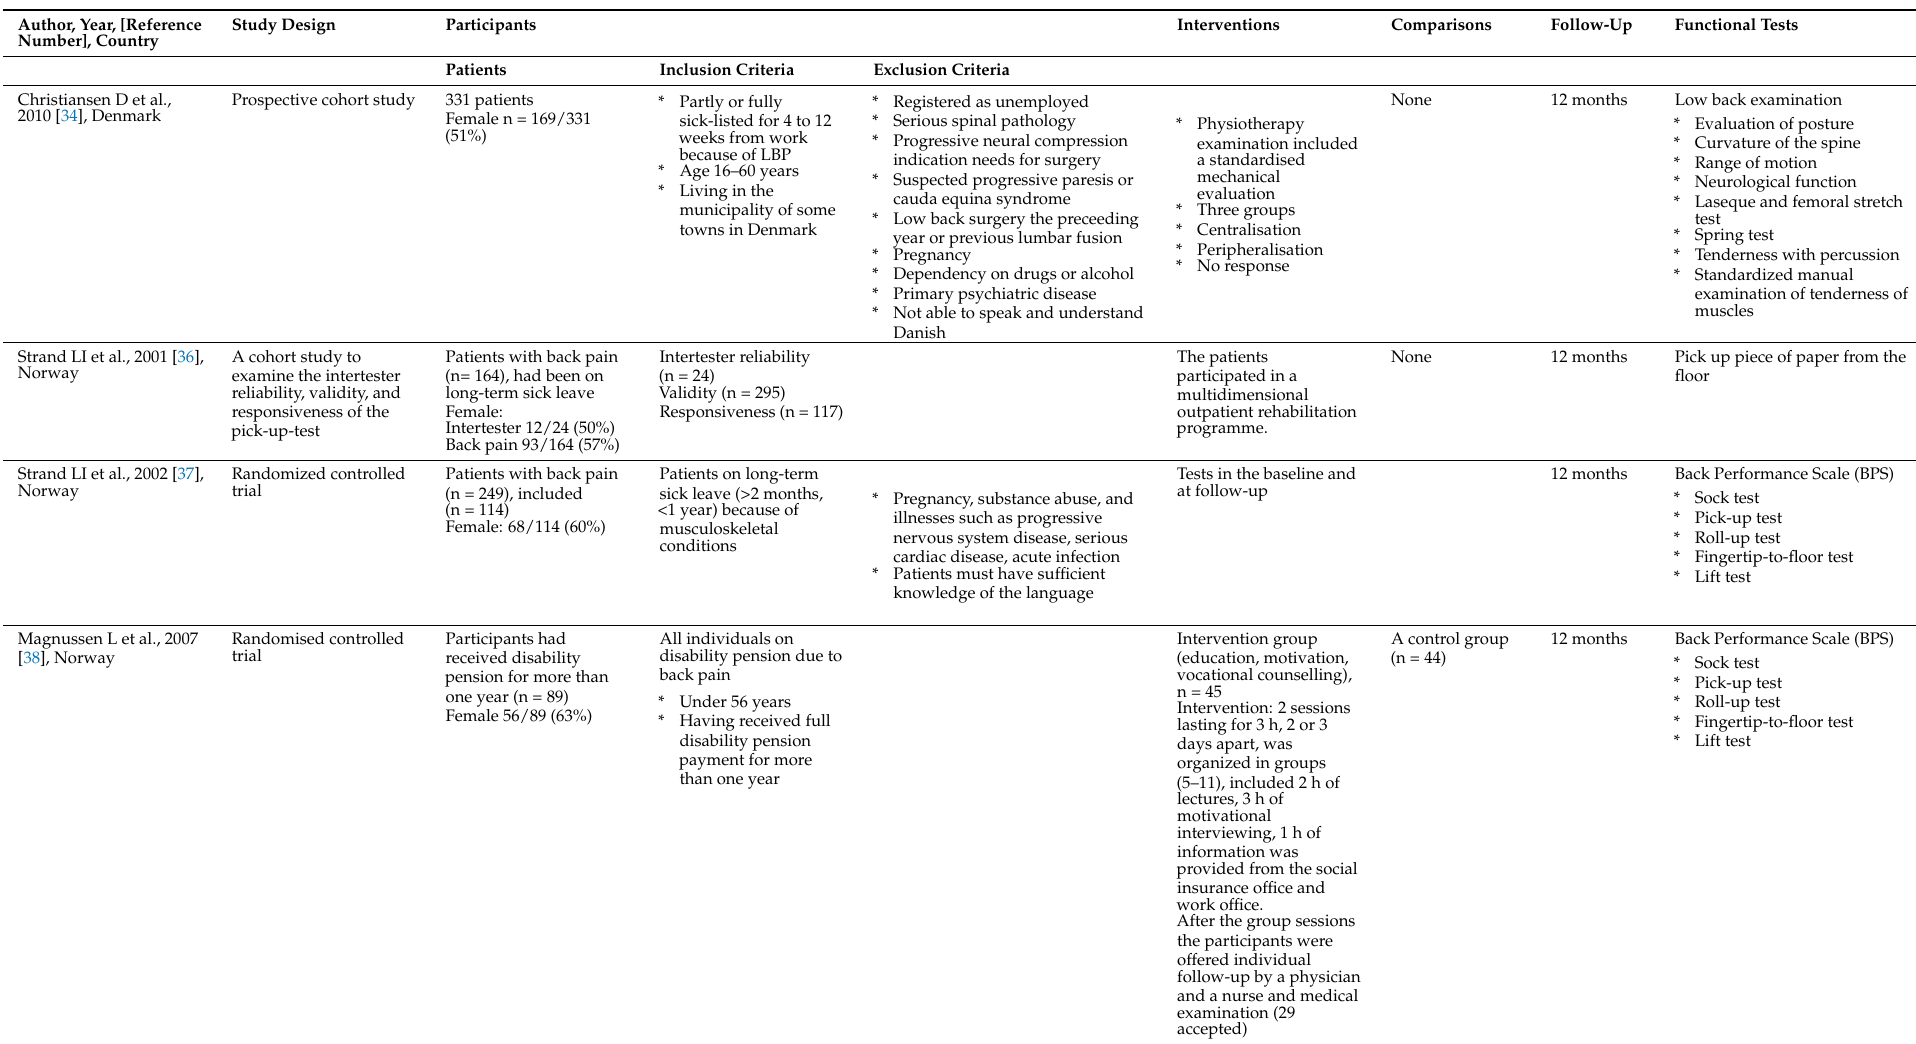
Table 2. Baseline details of the included